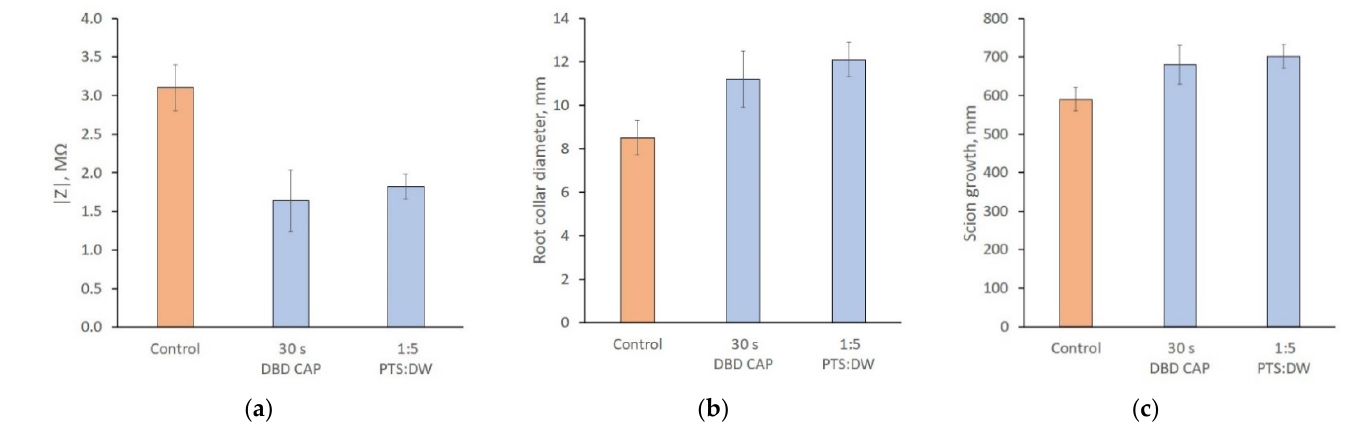
Figure 13. Graft zone impedance modulus after compensating for the electrode capacitive transition ( a ), the root collar diameter ( b ), and the scion growth ( c ) 6 months after grafting. Results are presented for 3 experimental groups: control, direct treatment with DBD CAP (30 s exposure duration), and indirect treatment with PTS diluted in DW with a 1:5 proportion. The number of samples in each experimental group is 30 and the number of measurement repetitions is 5. Data are presented as mean values and standard errors.